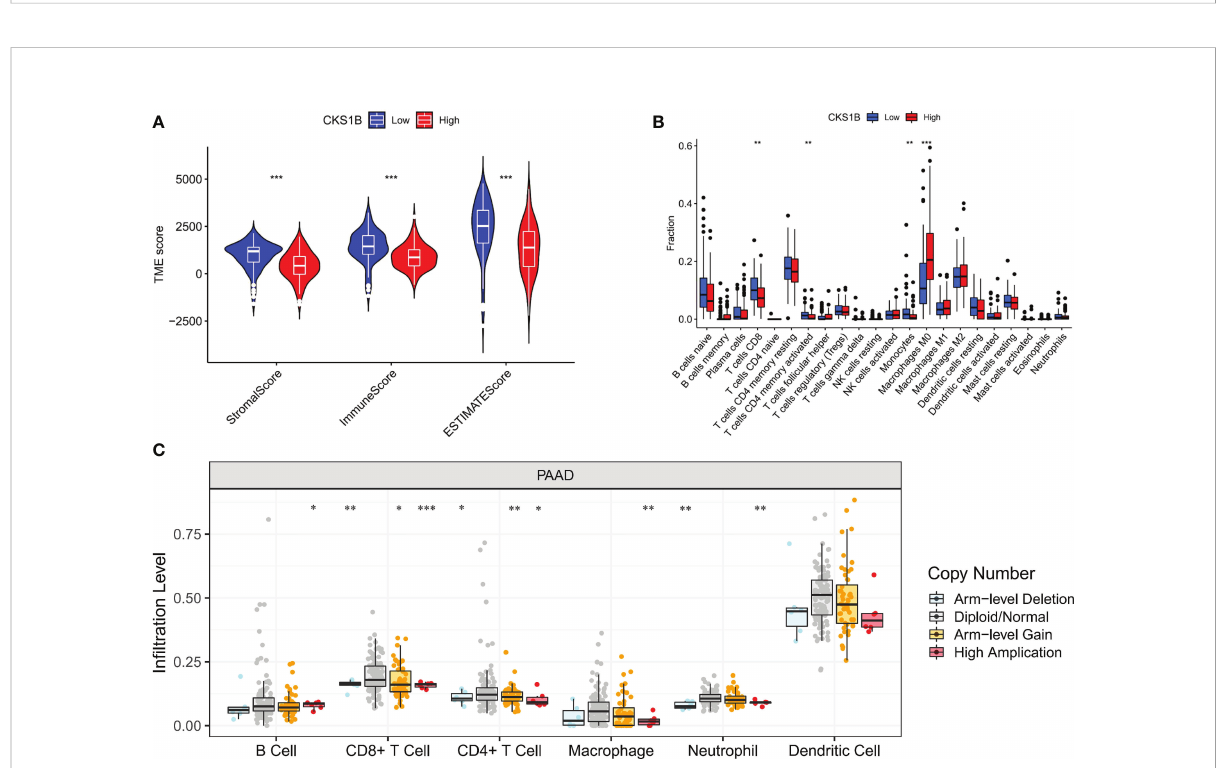
FIGURE 4 CKS1B expression is associated with immune cell in fi ltration in pancreatic cancer. (A) The immuneScore, stromalScore, and ESTIMATEScore between high and low CKS1B group. (B) The level of immune cell in fi ltration between the groups with high and low CKS1B expression. (C) The correlation of CKS1B somatic copy number alterations with immune cell in fi ltration. (*P<0.05,**P<0.01,***P<0.001)